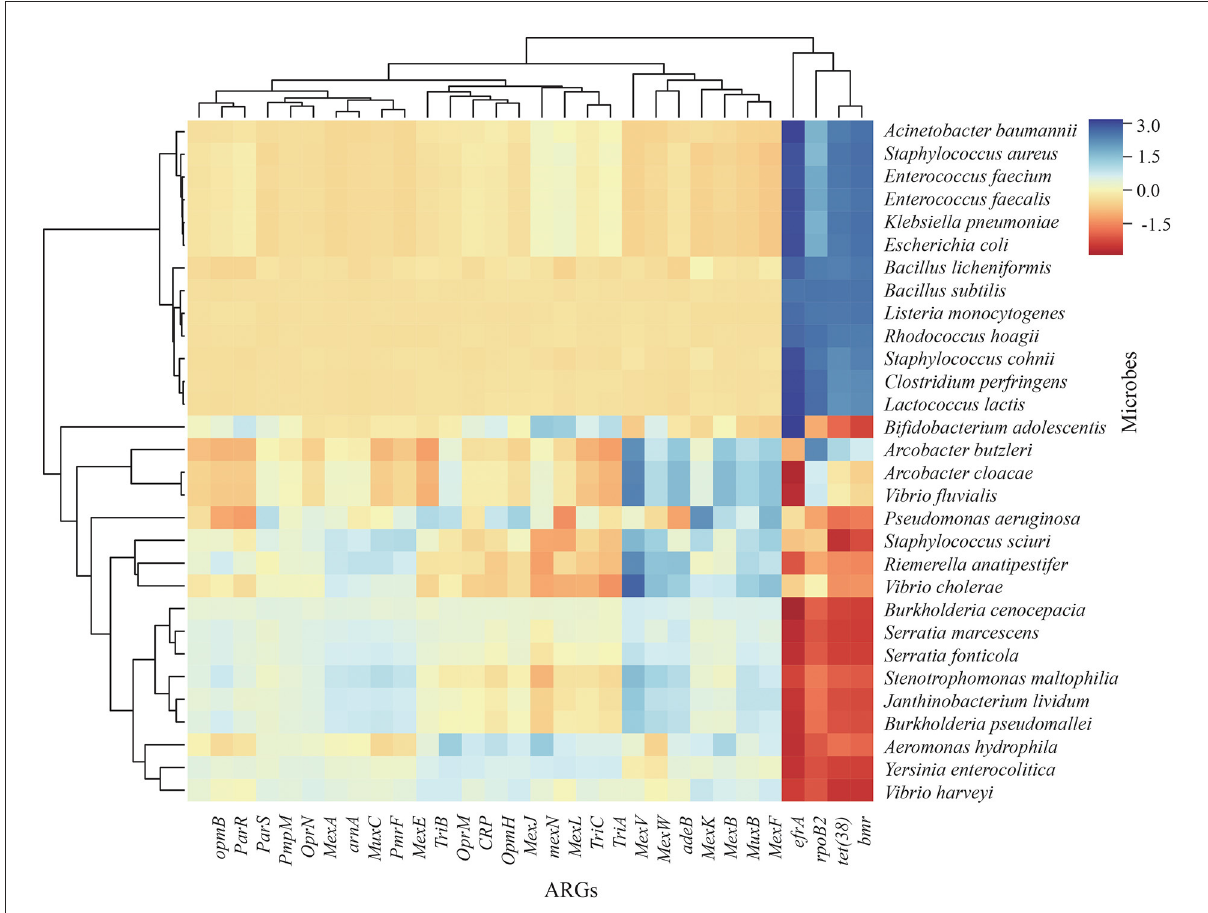
FIGURE7 Correlation heatmap of microbes and antibiotic-resistant genes (ARGs) in the gut of Anser erythropus sampled from Shengjin (SJ) and Caizi (CZ) Lakes.